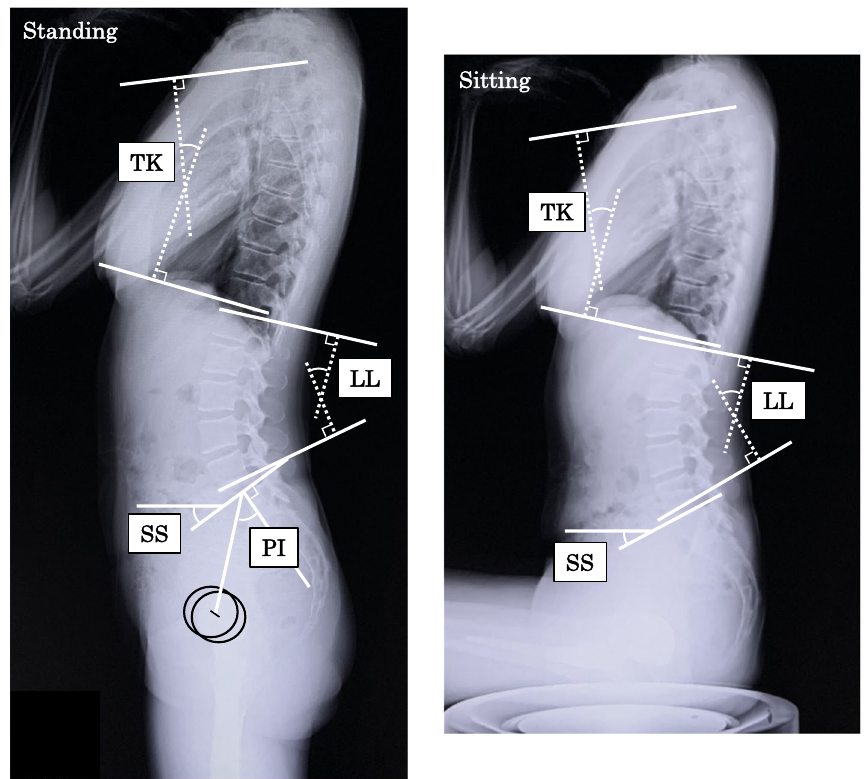
Fig. 2 Lateral radiographs of a patient in the standing (left) and sitting (right) positions. Illustration of the spinopelvic parameters. TK, thoracic kyphosis angle; LL, lumbar lordosis angle; SS, sacral slope; PI, pelvic